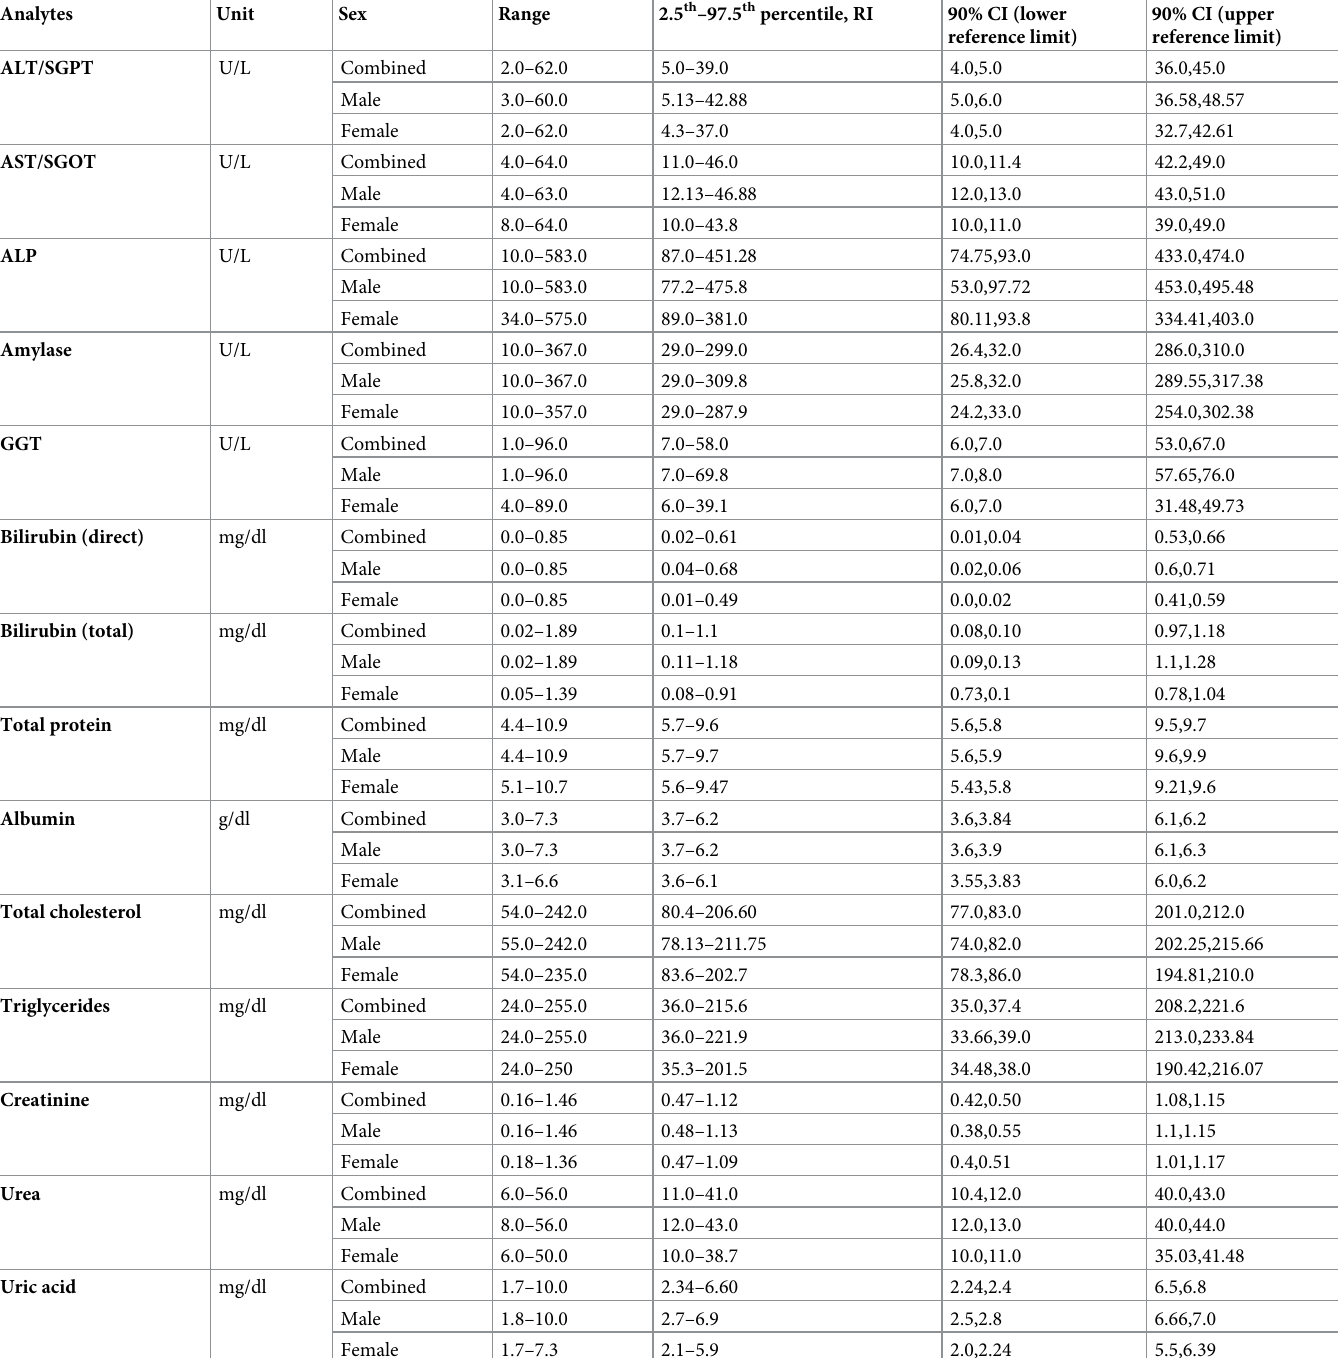
Table 3. The 90% CI of reference limits of clinical chemistry parameters RIs among blood donors in Amhara National Regional State, Ethiopia, 2017 (N = 1,175; Male = 644 and Female =